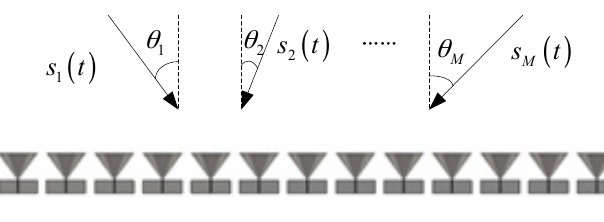
Figure 1. Setup of the array antenna.